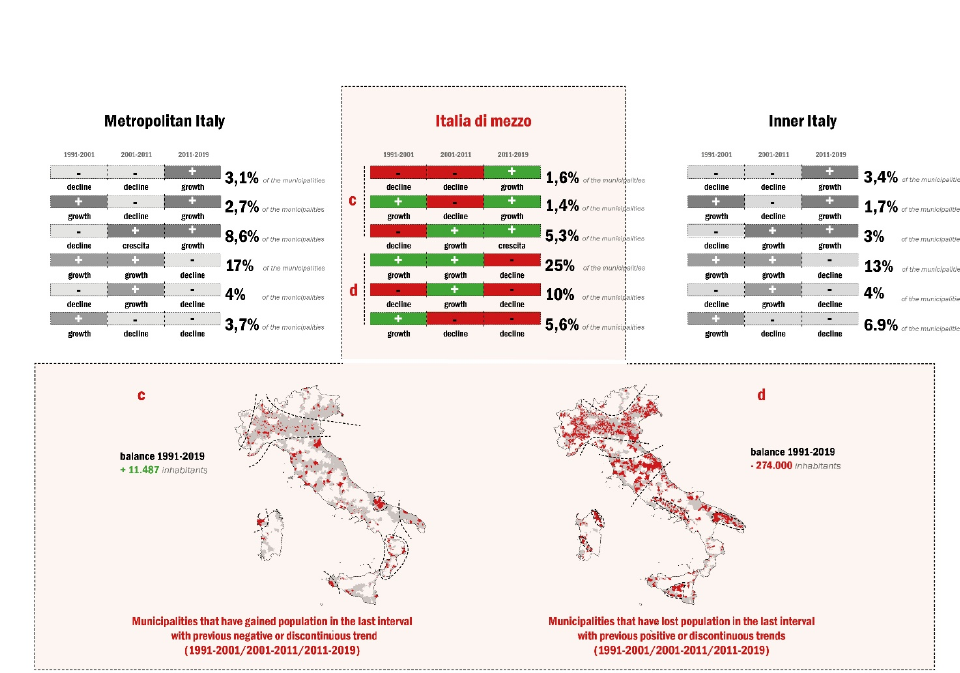
Figure 8: Contraction in non-homogeneous